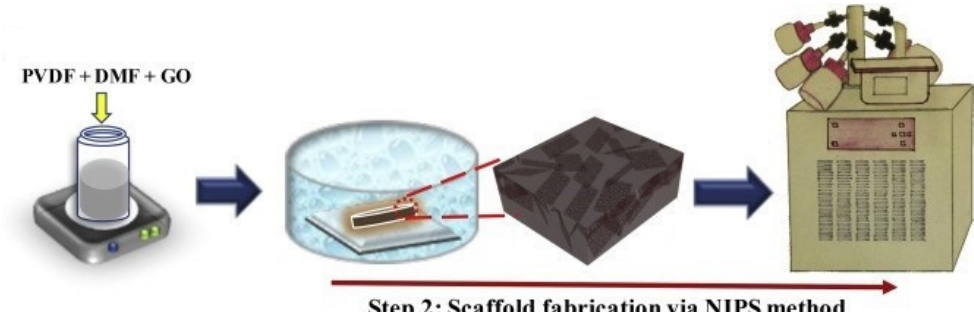
Figure 9. The schematic showing the immersion precipitation approach followed by a freeze-drying method to develop a porous PVDF-GO nanocomposite scaffold [108]. Reprint with permission from Elsevier.